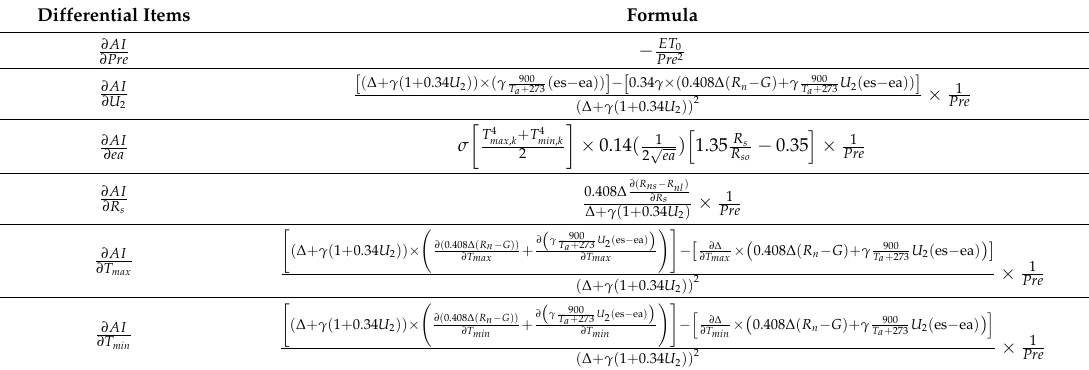
Table 1. Partial derivative formulas of aridity index to the climate